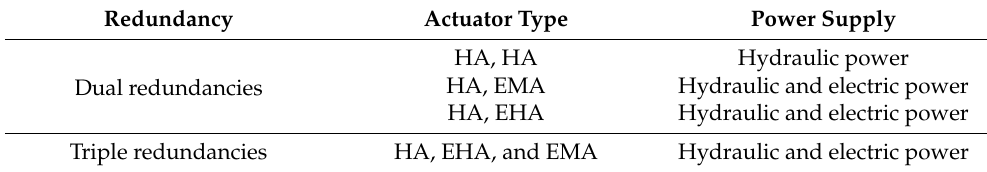
Table 1. Typical configuration of dissimilar redundant actuation system.